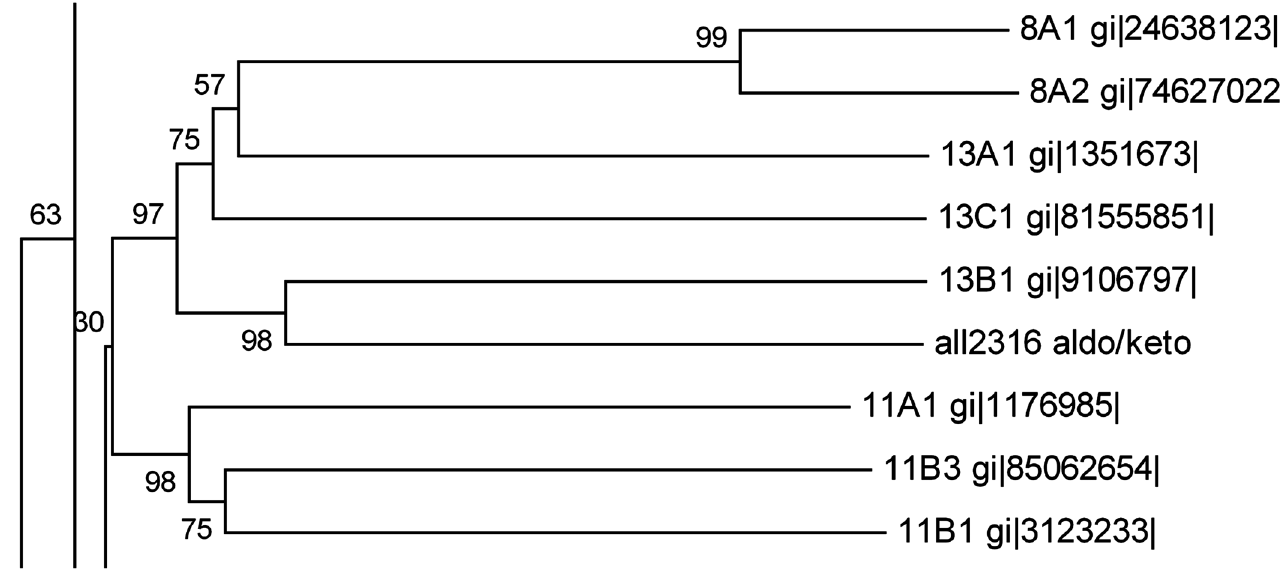
Fig 1. A segment of phylogenetic tree representing the relationship of ORF All2316 encoding Anabaena 7120 AKR to other closely related members of the AKR superfamily. Analysis involved all annotated AKRs (155 proteins) that fall into 15 families of AKR superfamily along with the new AKR from Anabaena 7120. The complete tree and the sequence alignment of the entire AKR protein sequences are given in supporting information (S1 and S2 Files). Full names for the sequences used in this figure are available on the AKR homepage